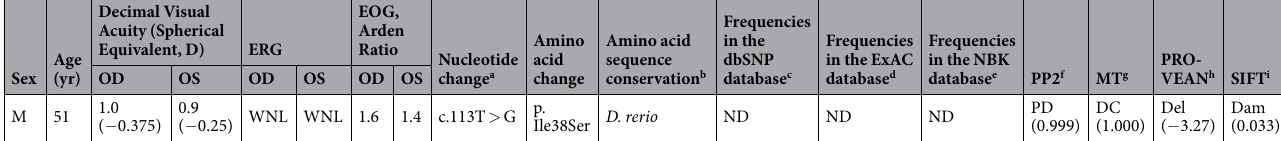
Table 1. Demography, Clinical Findings, and In Silico Analysis of the BEST1 mutation. Abbreviations are as follows: D, diopter; Dam, damaging; DC, disease causing; Del, deleterious; EOG, electro-oculogram; ERG, electroretinogram; M, male; ND, no data or DNA available; OD, right eye; OS, left eye; PD, probably damaging; PP2, PolyPhen-2 prediction score Humvar; PROVEAN, Protein Variation Effect Analyzer; SIFT, Sorting Intolerant from Tolerant; SNP, single nucleotide polymorphism; WNL, within normal limits; yr, years. a cDNA mutations are numbered according to human cDNA reference sequence NM_004183; + 1 corresponds to the A of ATG translation initiation codon. b Amino acid residue is continually conserved throughout evolution including the species as indicated. c dbSNP database (http://www.ncbi.nlm.nih.gov/SNP). d ExAC browser (http://exac.broadinstitute.org/). e National Biobank of Korea, the Centers for Disease Control and Prevention. f PolyPhen-2 prediction score HumVar ranges from 0 to 1.0; 0 = benign, 1.0 = probably damaging (http:// genetics.bwh.harvard.edu/pph2/). g Mutation taster (http://www.mutationtaster.org/). h PROVEAN (http:// provean.jcvi.org/index.php). i SIFT